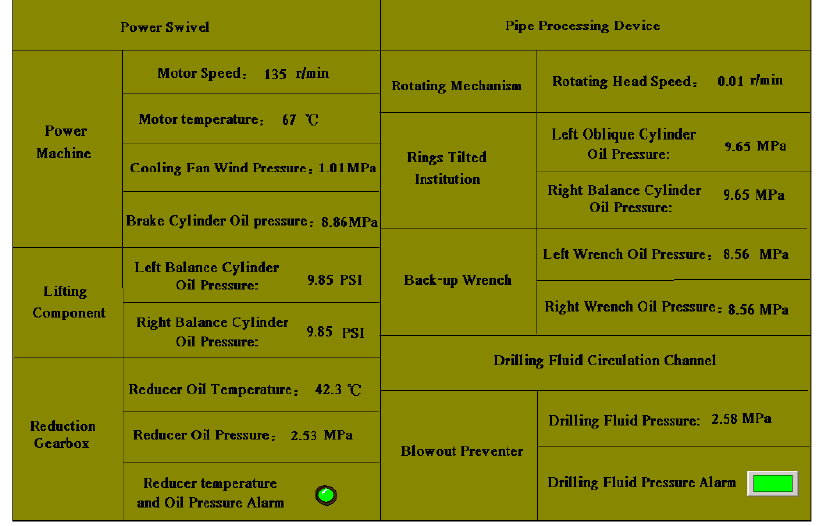
Figure 14. Configuration monitor screen of top drive.